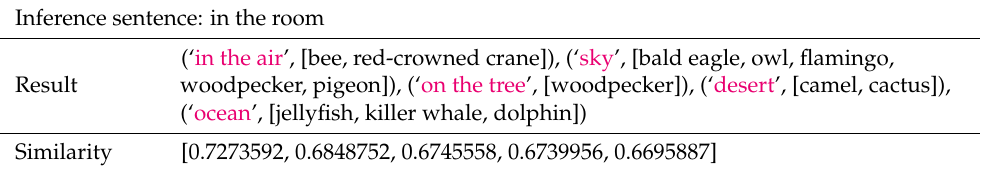
Table 17. Semantic reasoning result of using environment. Inference sentence: in the